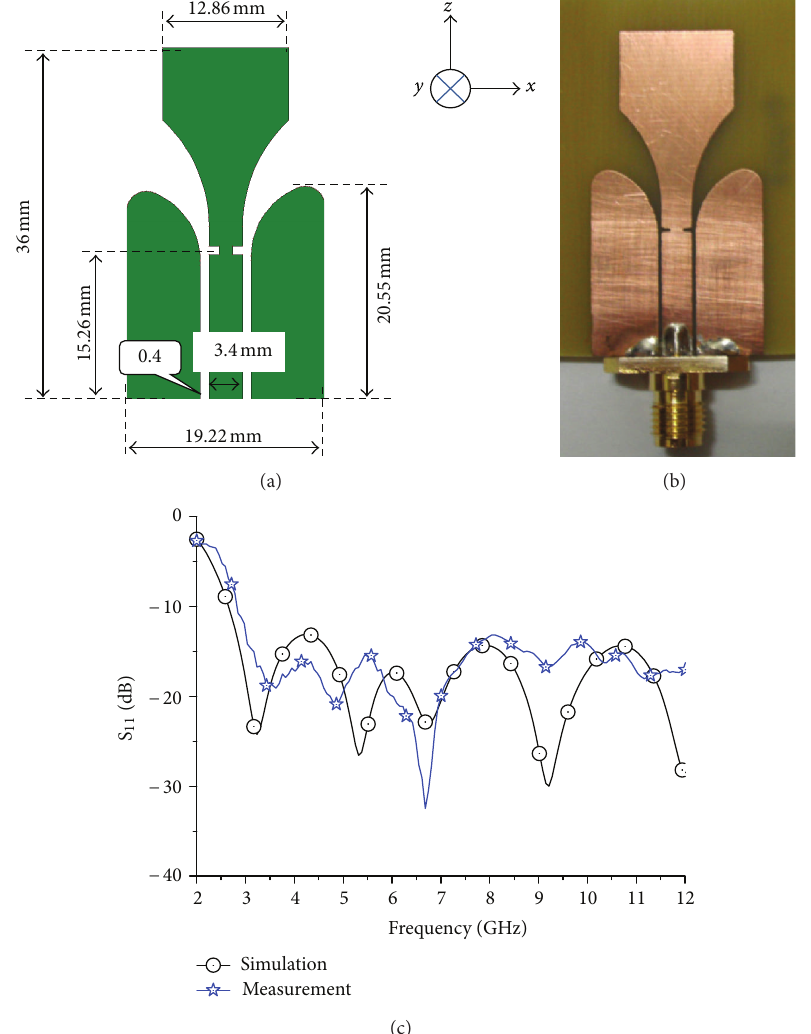
Simulation Measurement